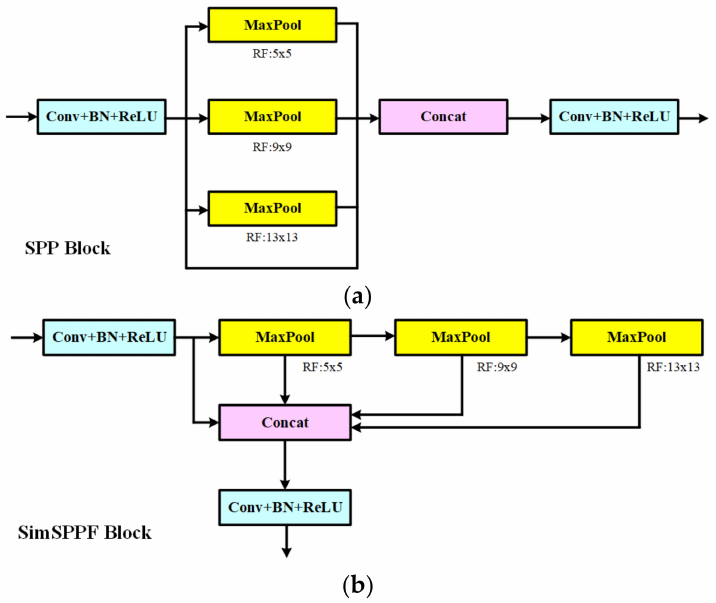
Figure 3. The structures of the SPP and SimSPPF block. “RF” represents the receptive